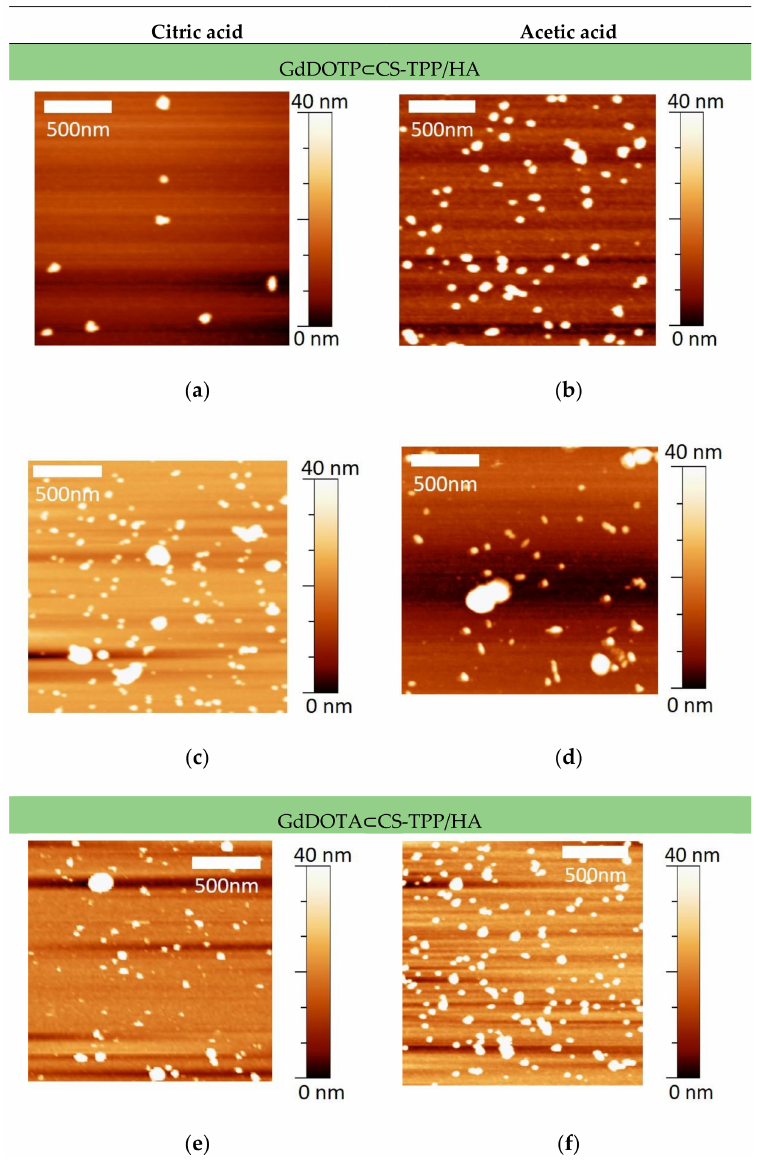
Figure 1. Atomic force microscopy (AFM) images in liquid of nanogels ( a – f ).